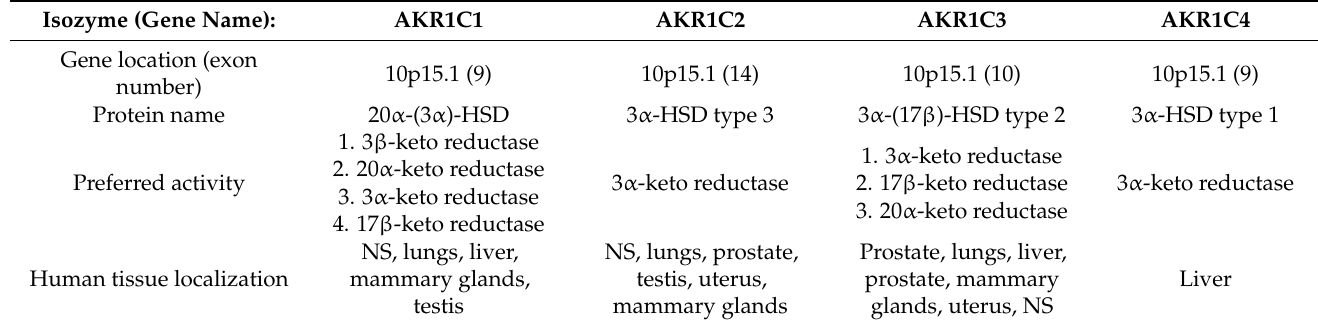
Table 2. Comparative characteristics of the AKR1C1-4 isozymes involved in the 3 α -reduction of